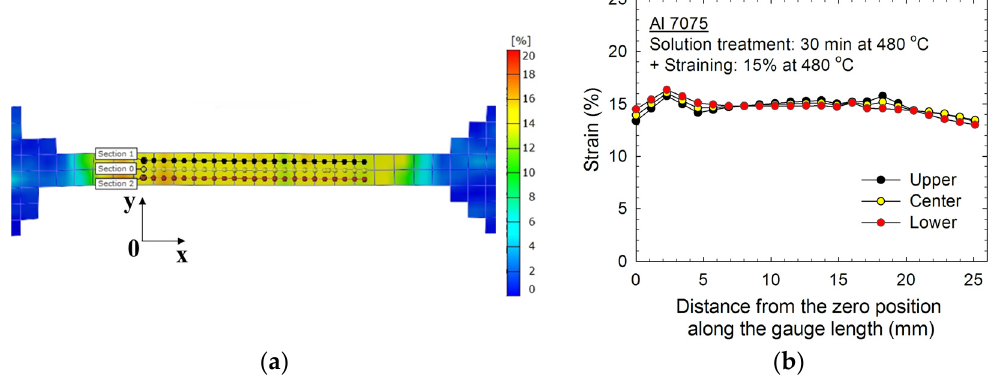
Figure 3. ( a ) A representative strain map for the specimen strained for 15% at 480 °C, where the measurement locations at three sections of upper, center, and lower are shown in black, yellow, and red dots, respectively, and the individual values of strain are represented by a set of unique color keys; and ( b ) variation of strain versus distance from the zero position at the three separate measurement sections along the gauge length in the Al 7075 after straining for 15% at 480 °C.